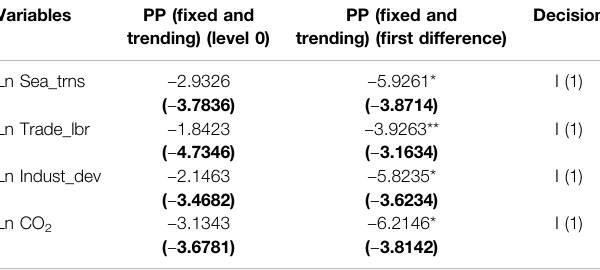
TABLE 2 | Zivot-andrews unit root test results of China. Variables First difference